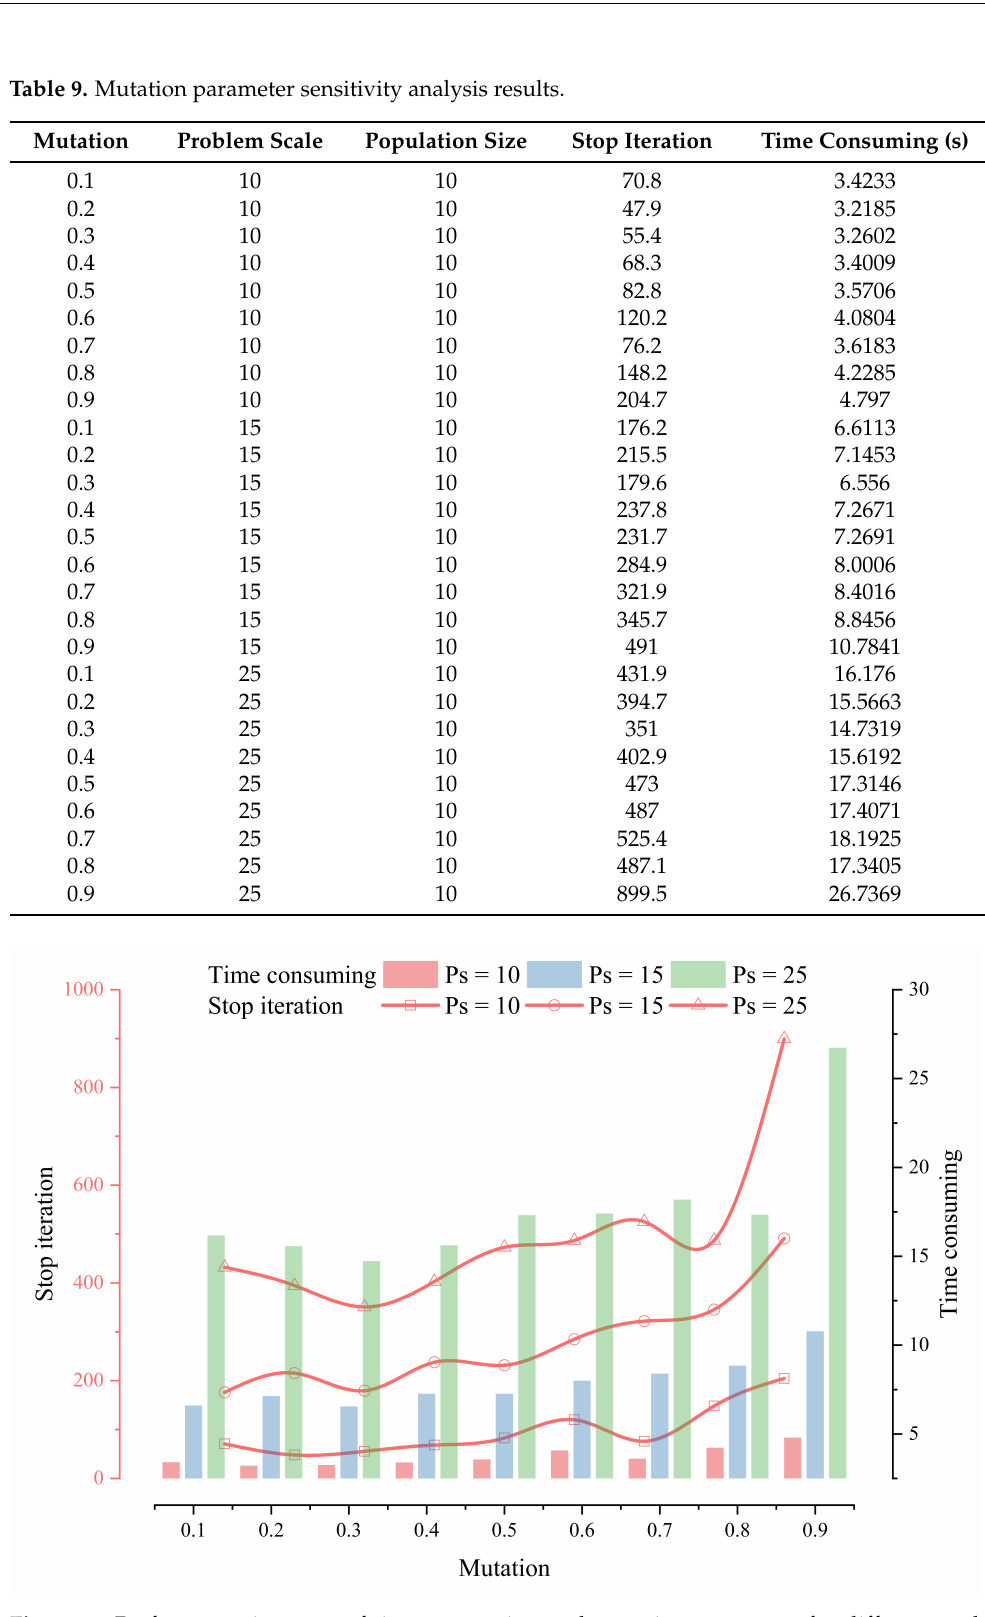
Figure 8. Performance in terms of time consuming and mutation parameter for different prob- lem